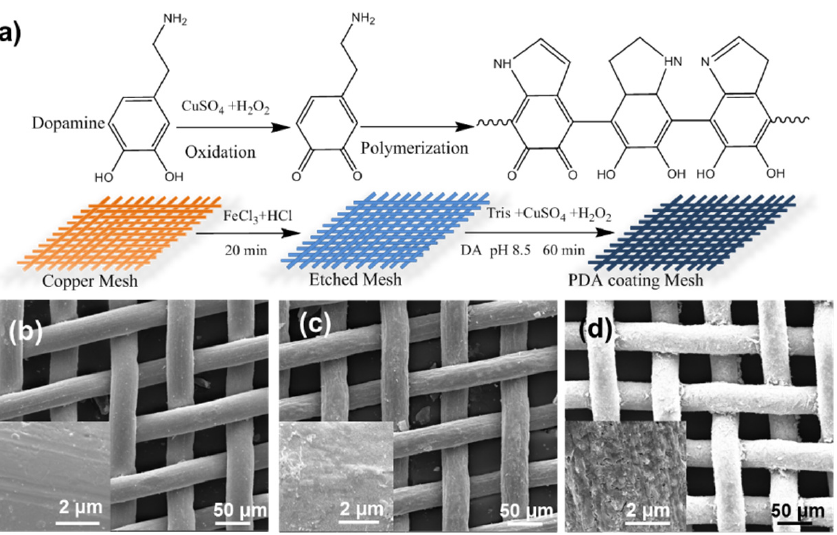
Figure 2. ( a ) Schematic description of the preparation of PDA-coated copper mesh. ( b ) SEM images of pristine copper mesh, ( c ) the etched mesh within 20 min and ( d ) the PDA decorated mesh within 60 min.